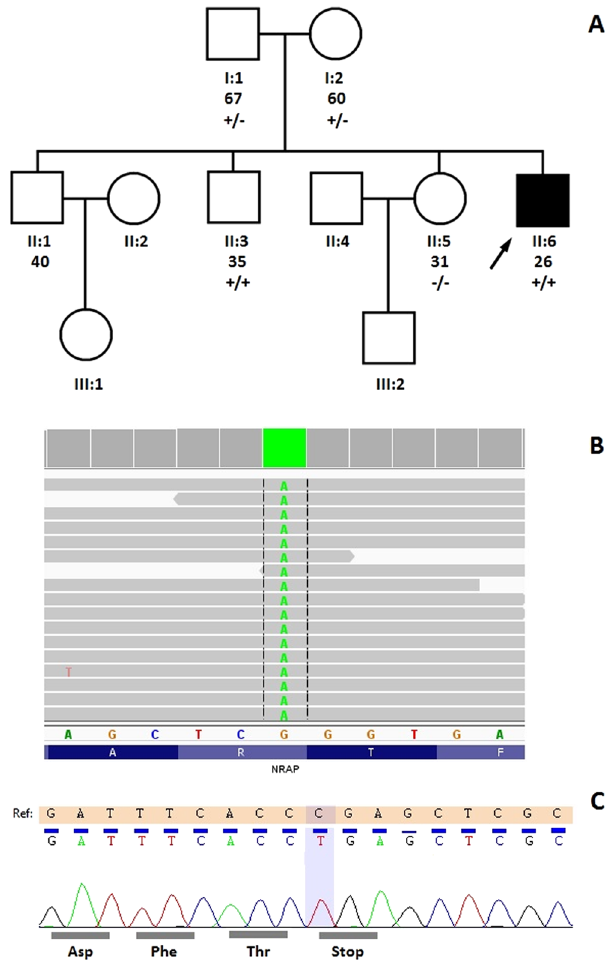
Figure 1. The NRAP NM_198060.3:c.4504C > T:p.Arg1502 * variant in the proband. Pedigree of proband family ( A ) and IGV view of the NRAP NM_198060.3:c.4504C > T:p.Arg1502 * variant found by whole exome sequencing ( B ) and chromatogram from direct sequencing by the Sanger method ( C ). Pedigree: squares represent males and circles represent females. An arrowhead denotes the proband. Solid black symbols denote dilated cardiomyopathy and open symbols unaffected individuals. The presence or absence of the NRAP variant is indicated by a + / − symbol.